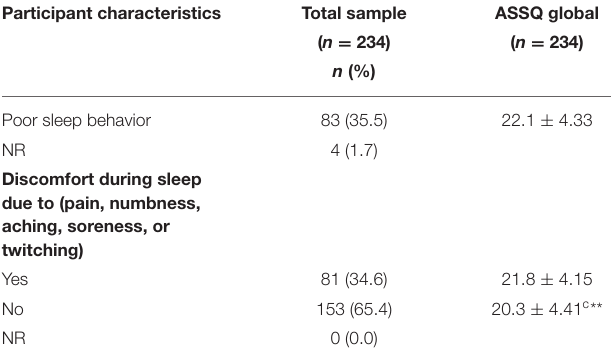
TABLE 1 | Sleep quality (ASSQ global score) by participant